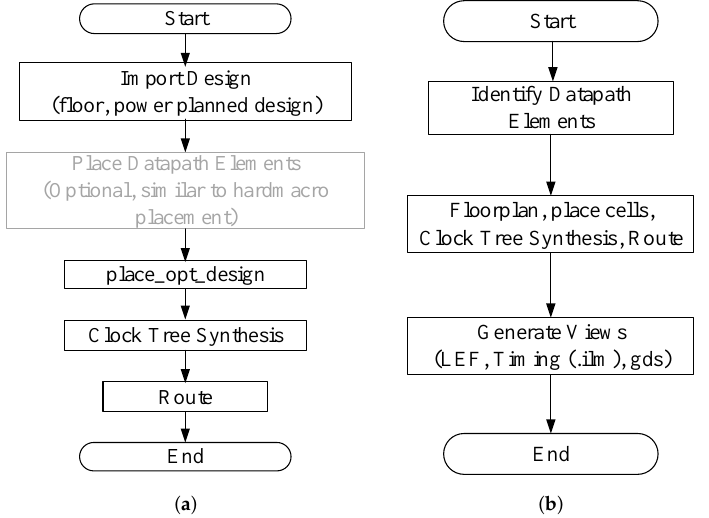
Figure 3. Traditional Design flow for Standard cell-based Design. ( a ) Traditional Design Flow. ( b ) Datapath Hardening